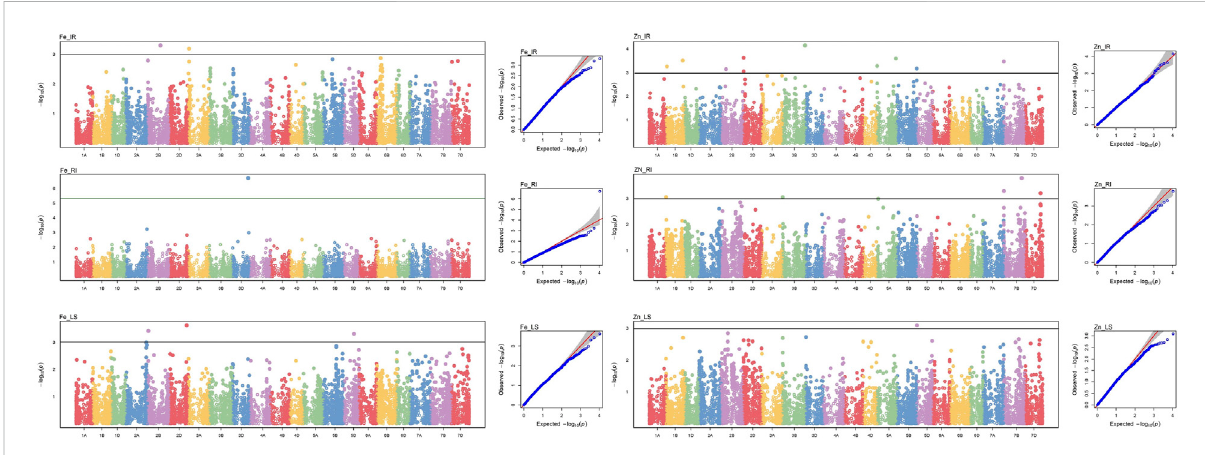
FIGURE 2 Manhattan and respective Q – Q plots of signi fi cant associations for GFeC and GZnC under IR, RI, and LS conditions.